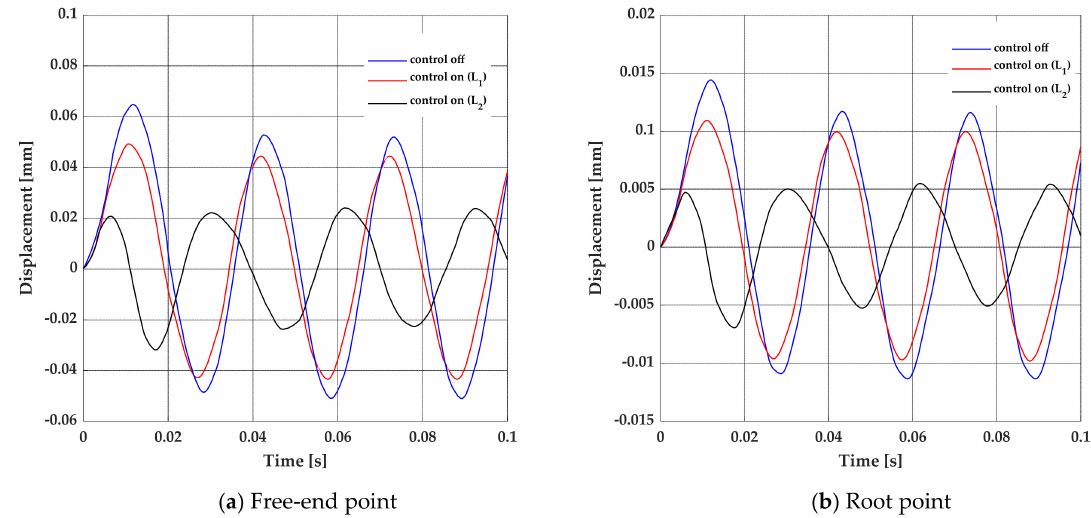
Figure 7. Dynamic displacement of beam (time history), circuit with di ff erent